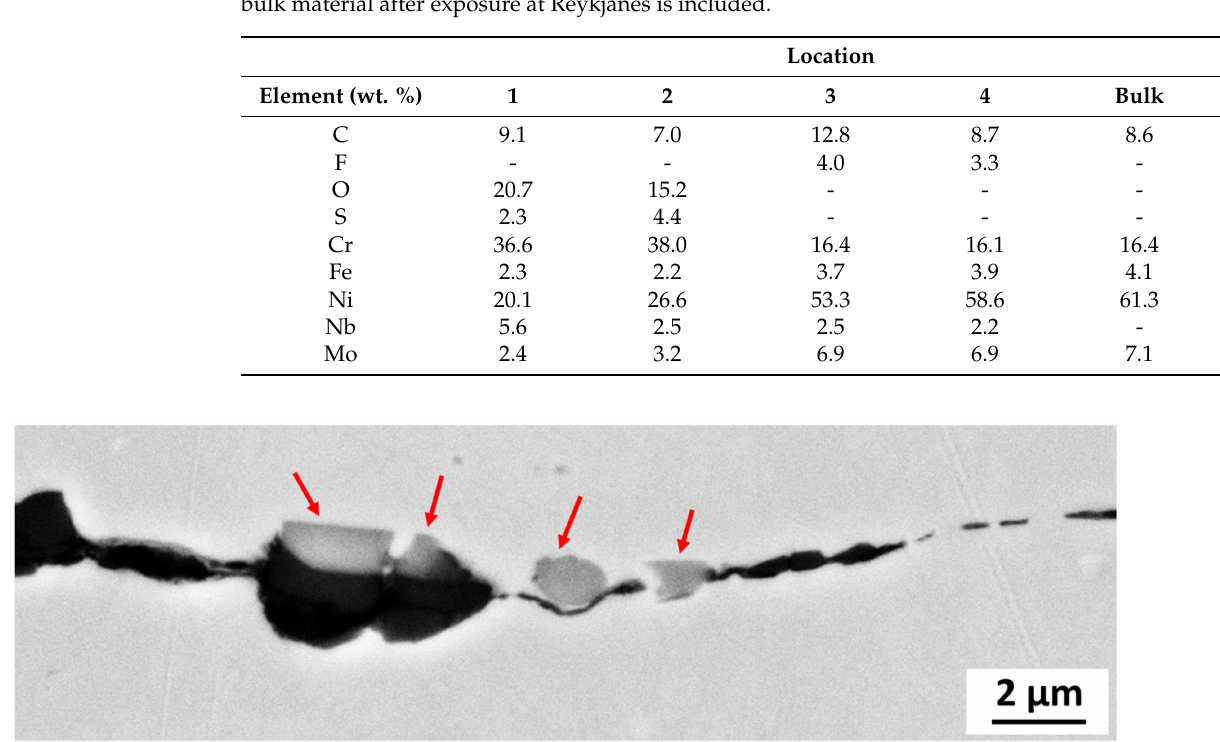
Figure 12. SEM cross-sectional image of the Inconel 625 after exposure in Chaunoy where inclusions are seen within crack propagation, marked with arrows.